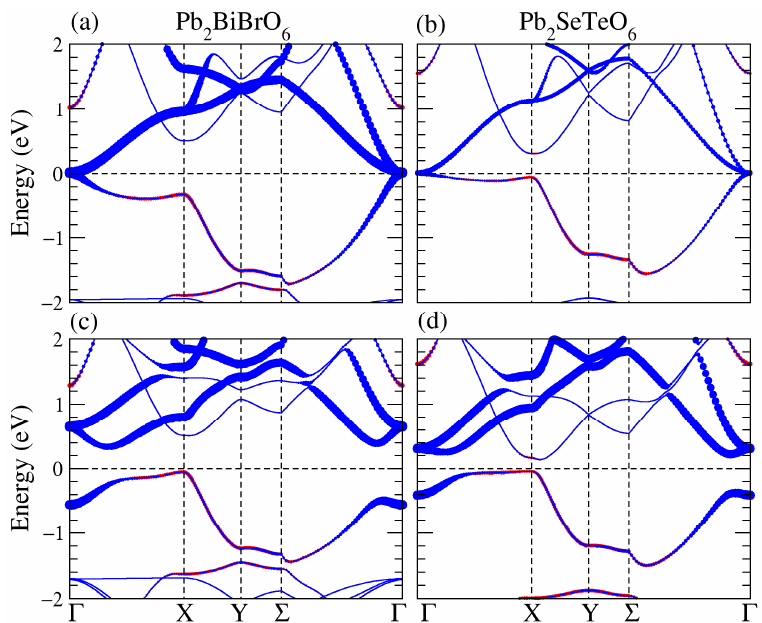
Figure 3. Scalar relativistic, ( a , b ), and fully relativistic, ( c , d ), electronic band structures of the Pb 2 BiBrO 6 and Pb 2 SeTeO 6 double perovskites projected onto the s -(red) and p -(blue) orbitals. Note that only BiBr (SeTe) s - and p -orbitals are projected. The Fermi energy is shifted to zero as a